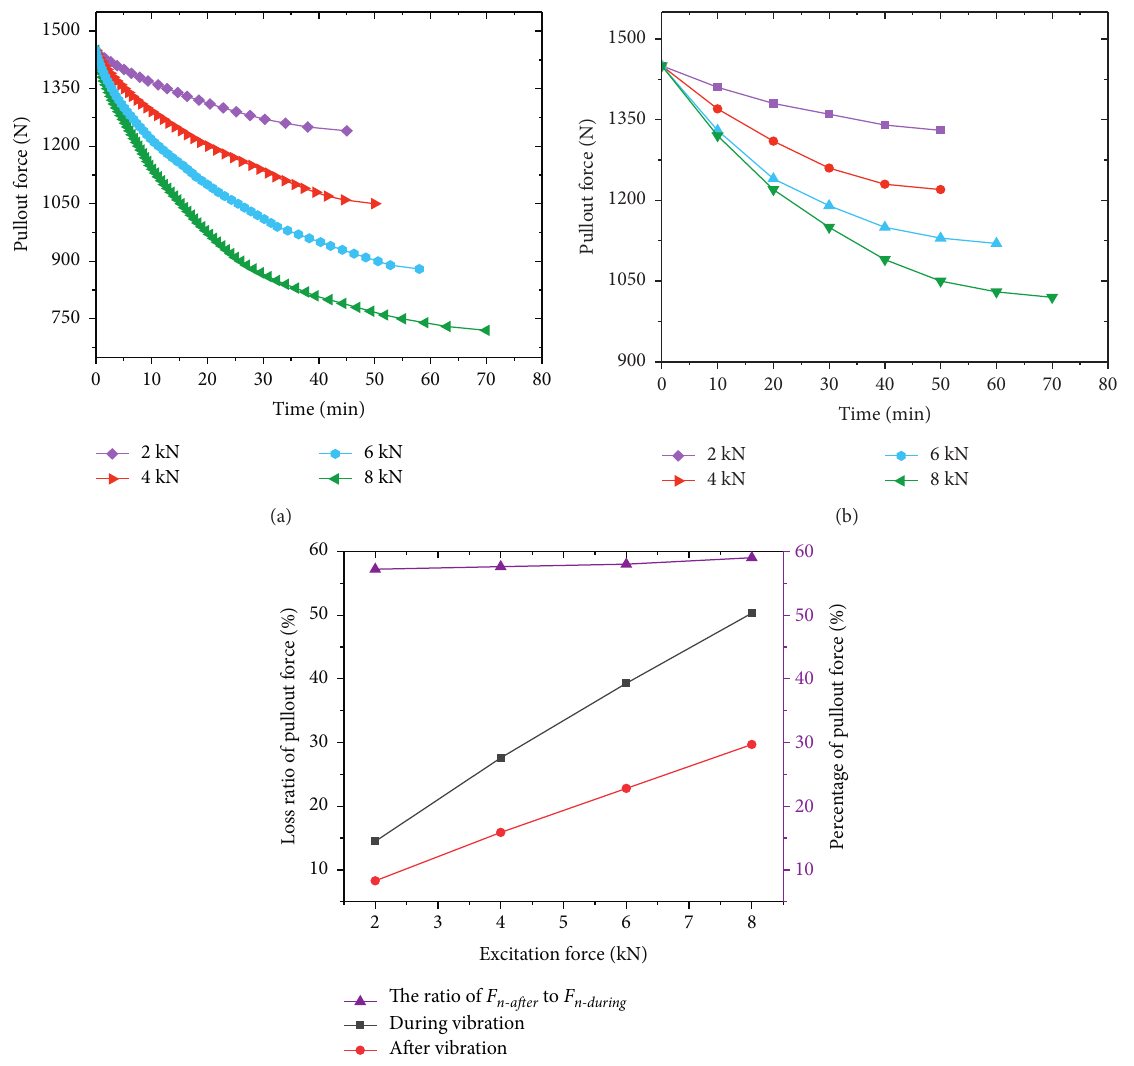
Figure 13: The variation of pullout force with time under different excitation forces. (a) During vibration. (b) After vibration. (c) Loss ratio of pullout force ( ∗ the ratio of the change of the pullout force to the initial prepullout